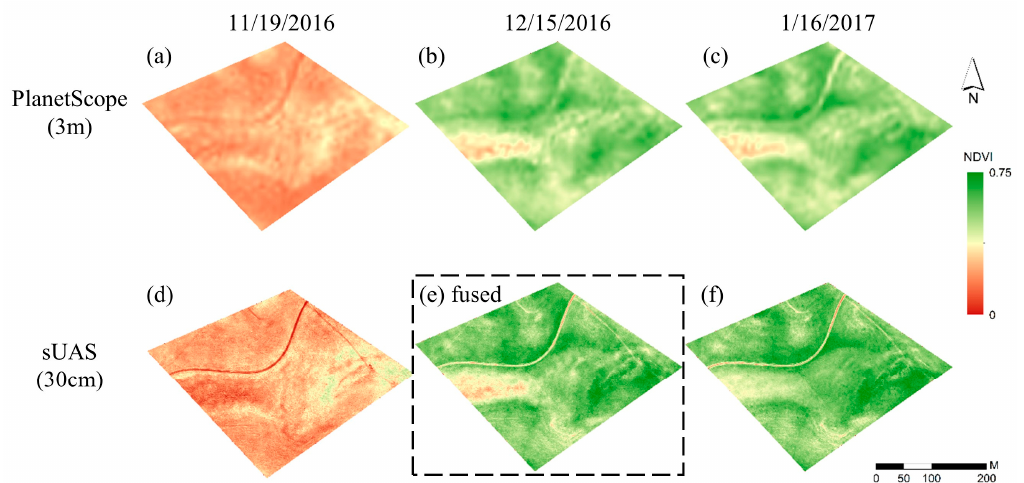
Figure 6. NDVI maps at PlanetScope resolution (upper panels) and sUAS resolution (bottom panels). Concurrent images were available on November 19, 2016 ( a , d ) and 16 January 2017 ( c , f ), while only a PlanetScope image was available on 15 December 2016 ( b ). The predicted NDVI image from data fusion at 30-cm resolution on December 15, 2016 is shown in ( e ).